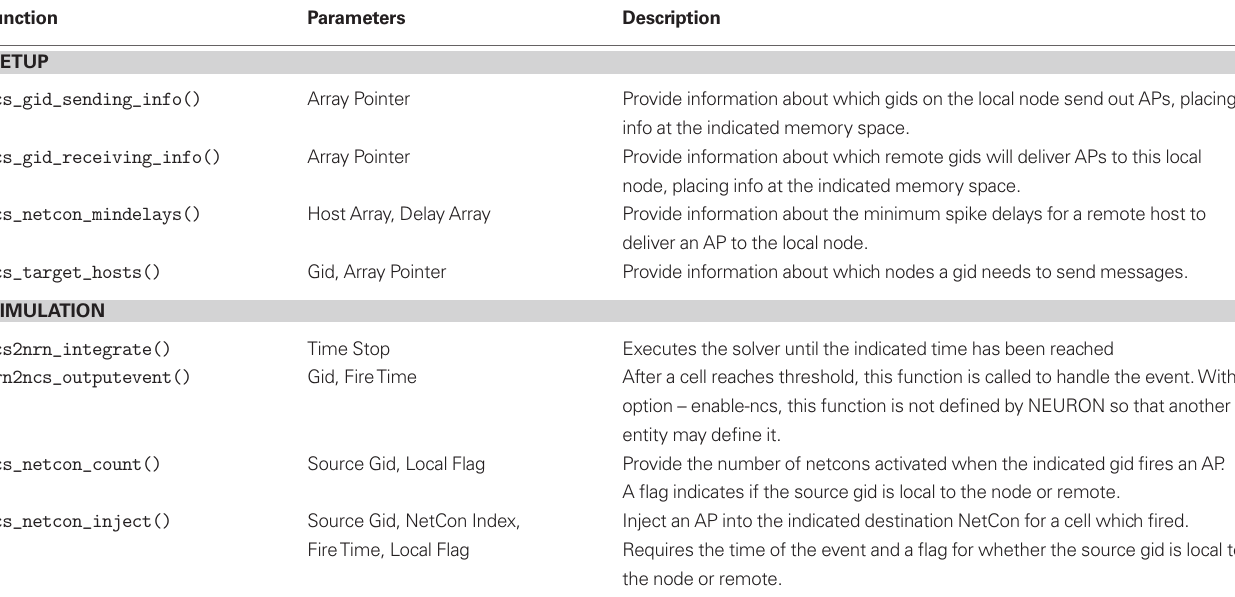
Table 2 | Interface functions provided by NEURON once confi gured and compiled with the option – enable-ncs. Function Parameters